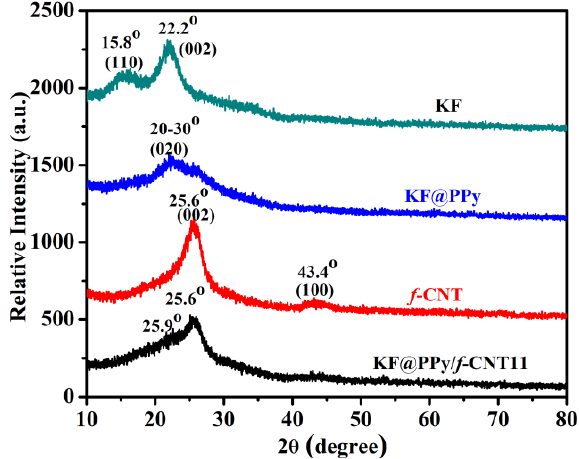
Figure 4. XRD patterns of KF, KF@PPy, f -CNTs, and KF@PPy/ f -CNT11.